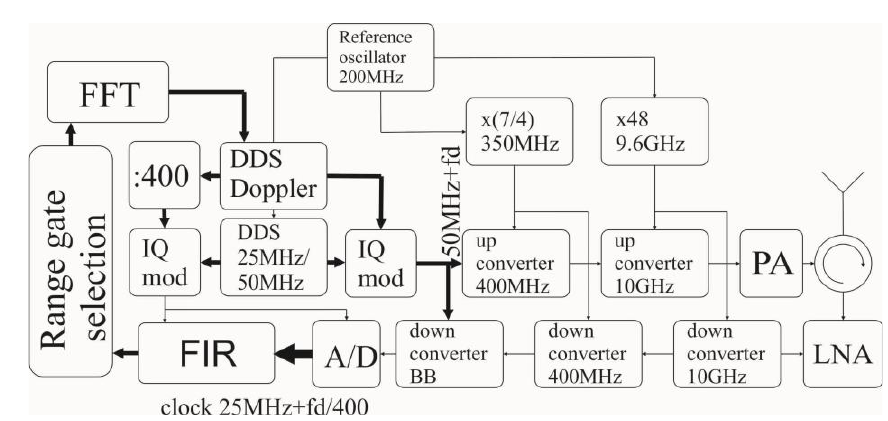
Figure 1 – Simplified block schematic of the tracking radar Рис. 1 – Упрощенная блок-схема РЛС слежения Слика 1 – Упрошћена блок-шема радара за